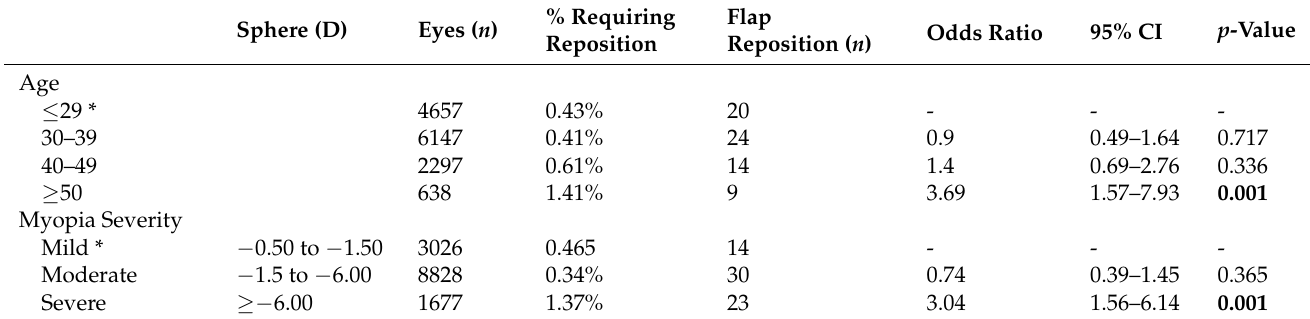
Table 3. Preoperative risk factors for flap